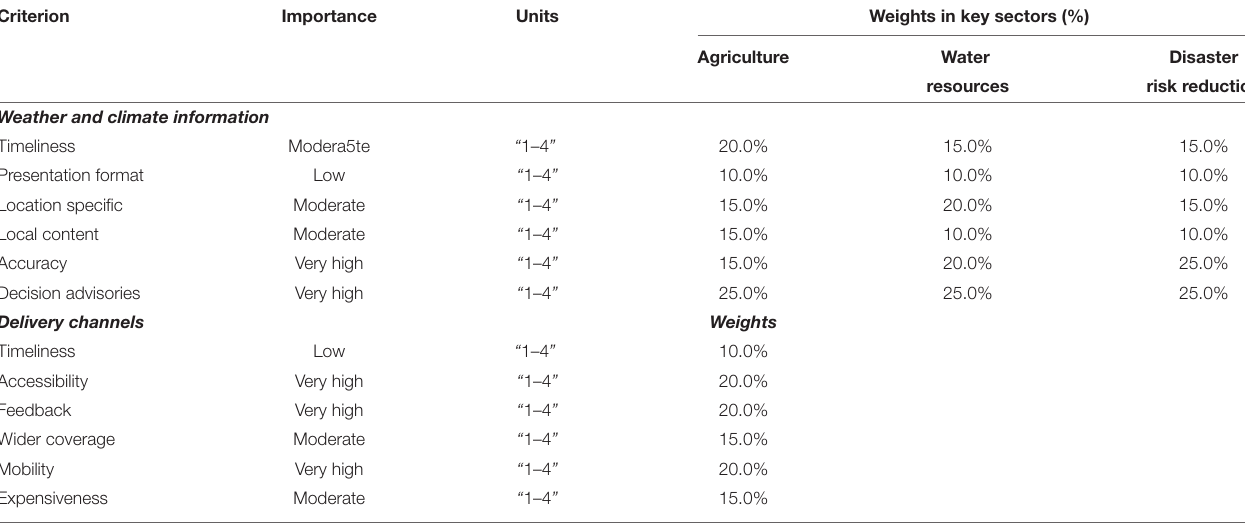
TABLE 7 | Weighted criteria weighted for alternative